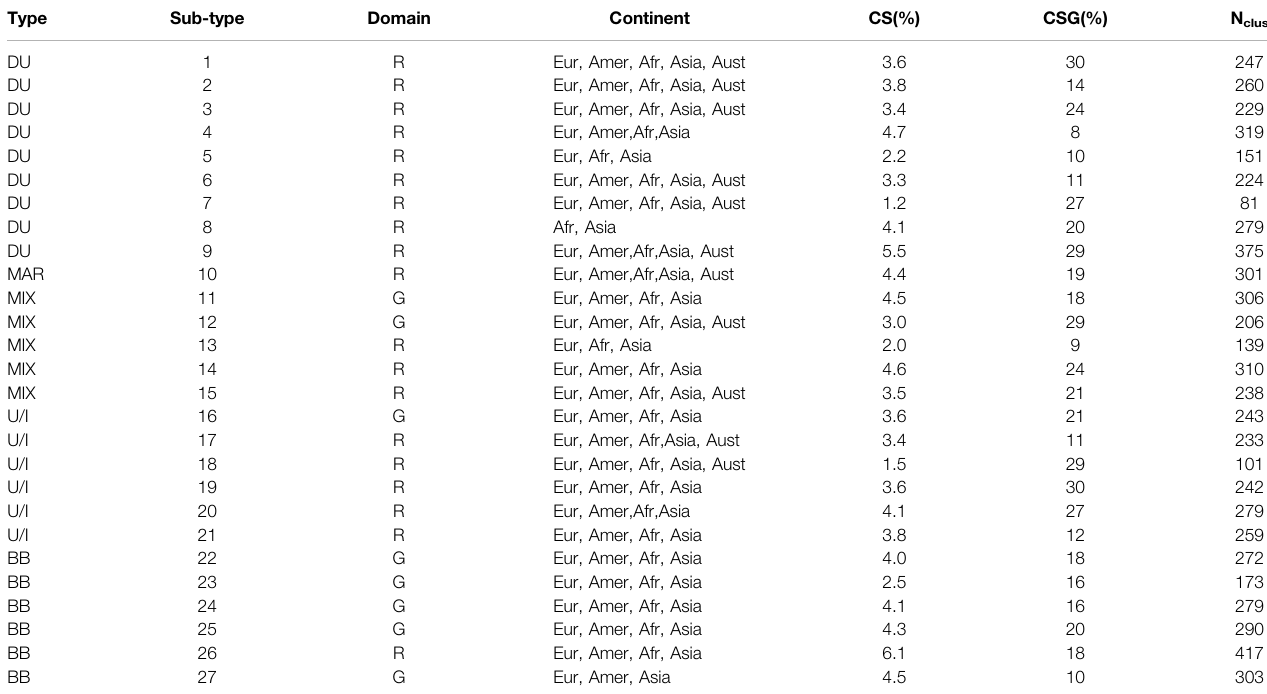
TABLE3| PAM-derivedaerosolmodels.G:global,R:regional,Eur:Europe,Amer:America,Aust:Australia,Afr:Africa,N clus :numberofrecordspercluster,CS:ClusterSize, CSG: Cluster Structure Goodness. Type